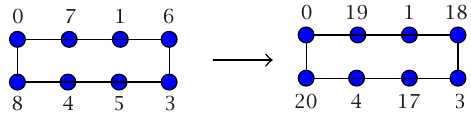
Figure 3.2 . Transformations of an α -labeling of the graph C